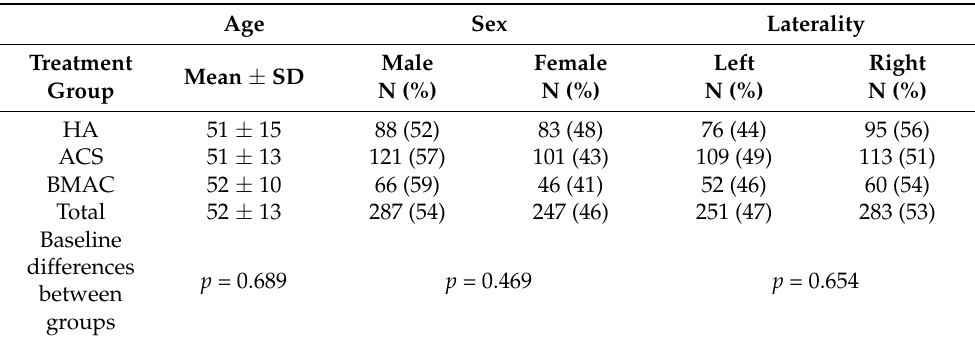
Figure 1. Flowchart of the study showing the number of eligible patients, number of included patients and number of included knees, reasons for exclusion and follow-up percentage at 3 and 12 months. HA = hyaluronic acid; ACS = autologous conditioned serum; BMAC = bone marrow aspirate concentrate. Table 1. Demographic data of the included